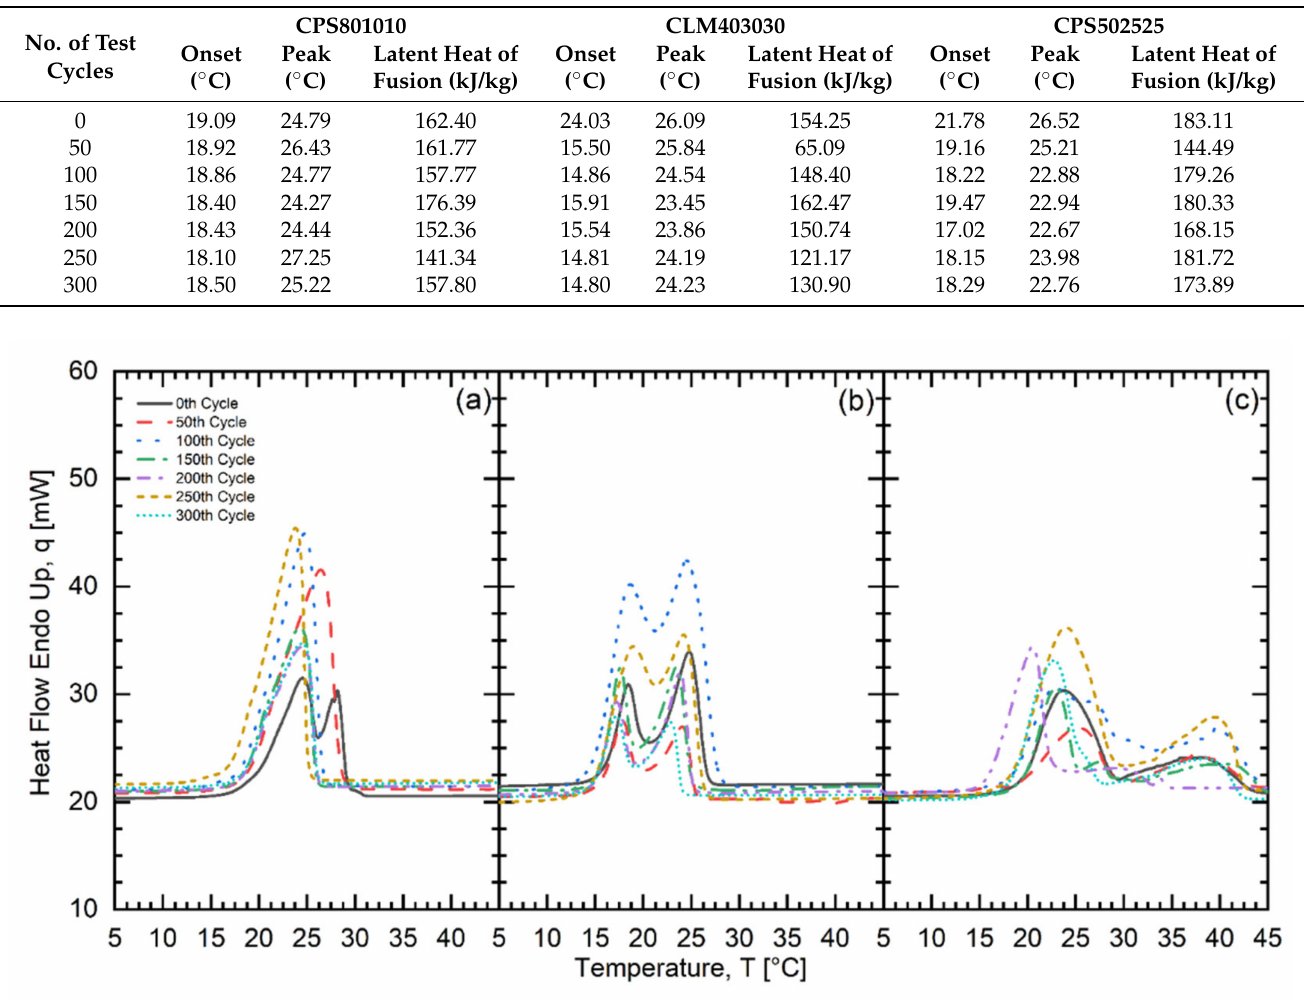
Table 9. Latent heat of fusion and melting temperature of developed materials with test cycles (CPS801010, CLM403030, CPS502525).